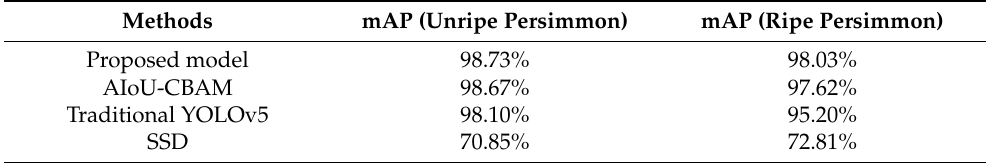
Table 3. Detection results of the four model indicators.